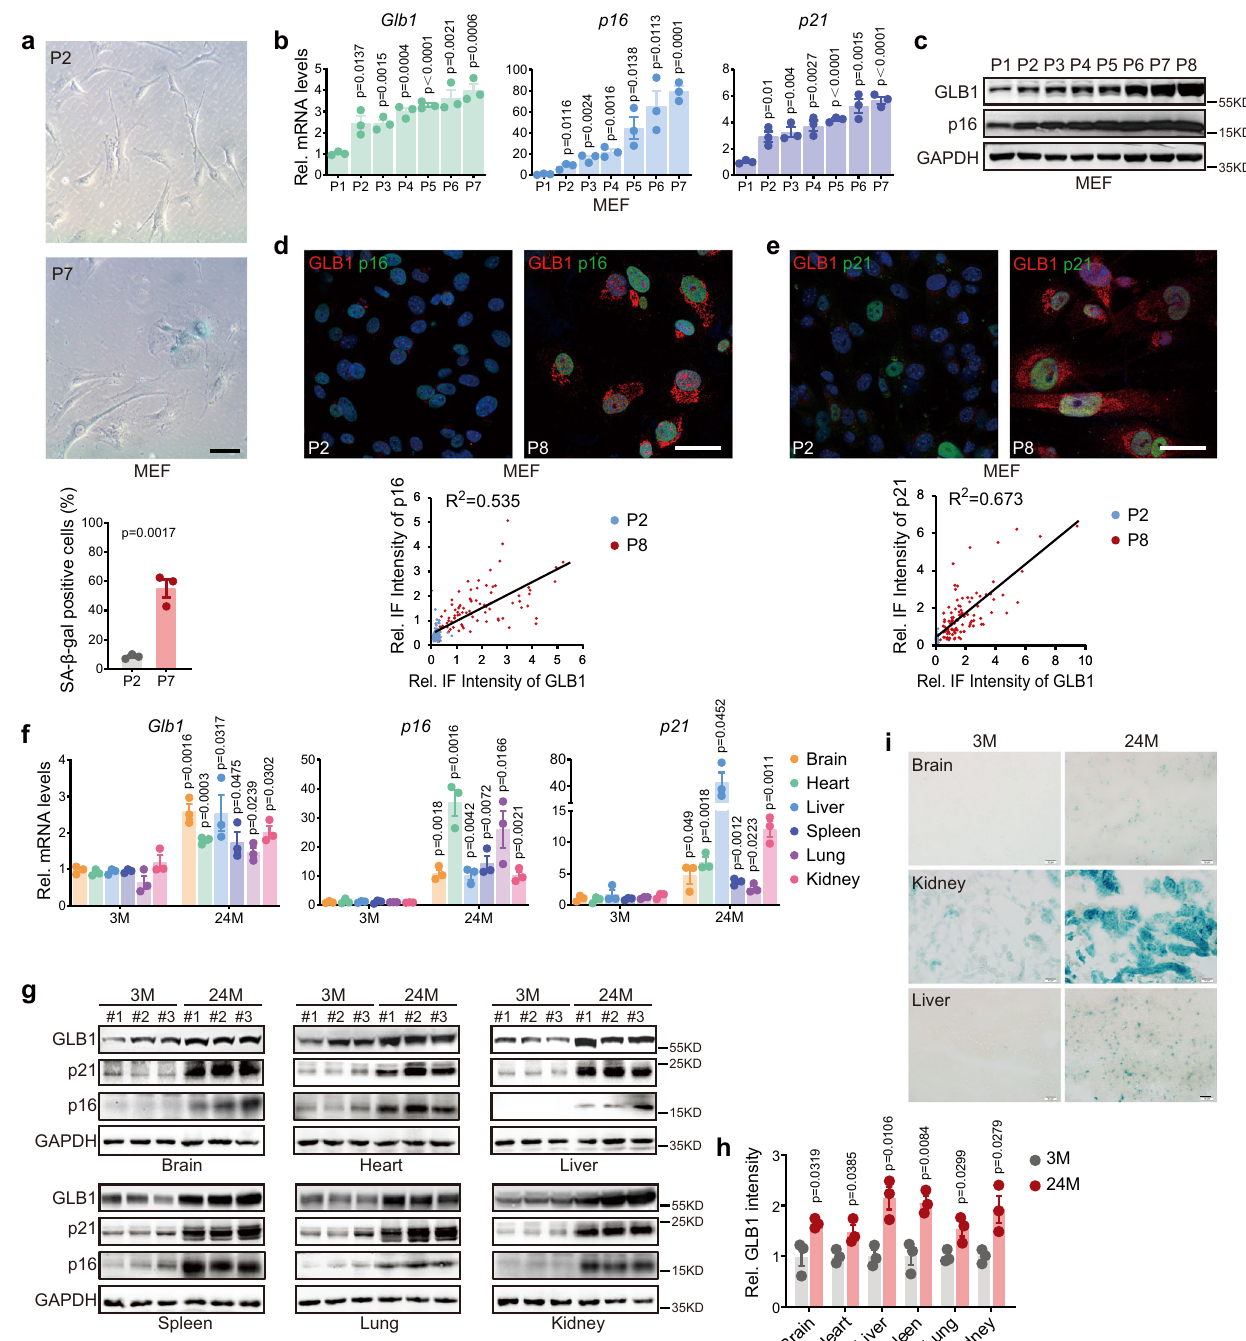
Fig. 1 | Increased Glb1 mRNA and protein levels in cell and tissue aging. Increased SA β -gal with quanti fi cation of percent positive cells (bottom panel, over 100 cells per group were counted) and enlarged cell morphology ( a ), elevated mRNAlevelsof Glb1 , p16 Ink4a ,and p21 Wif1 ( b ),and upregulatedproteinlevelsofGLB1 and p16 Ink4a ( c ) in mouse embryonic fi broblasts (MEFs, from n =3 embryos of wild- type C57BL6 mice) during replicative senescence. Scale bar, 100 µ m. Representa- tiveimagesshowingco-stainingofGLB1(red)andp16 Ink4a (green)( d ,quanti fi cation of correlation between two signals in lower panel, over 80 cells per group were counted), and co-staining of GLB1 (red) and p21 Wif1 (green) ( e , quanti fi cation of